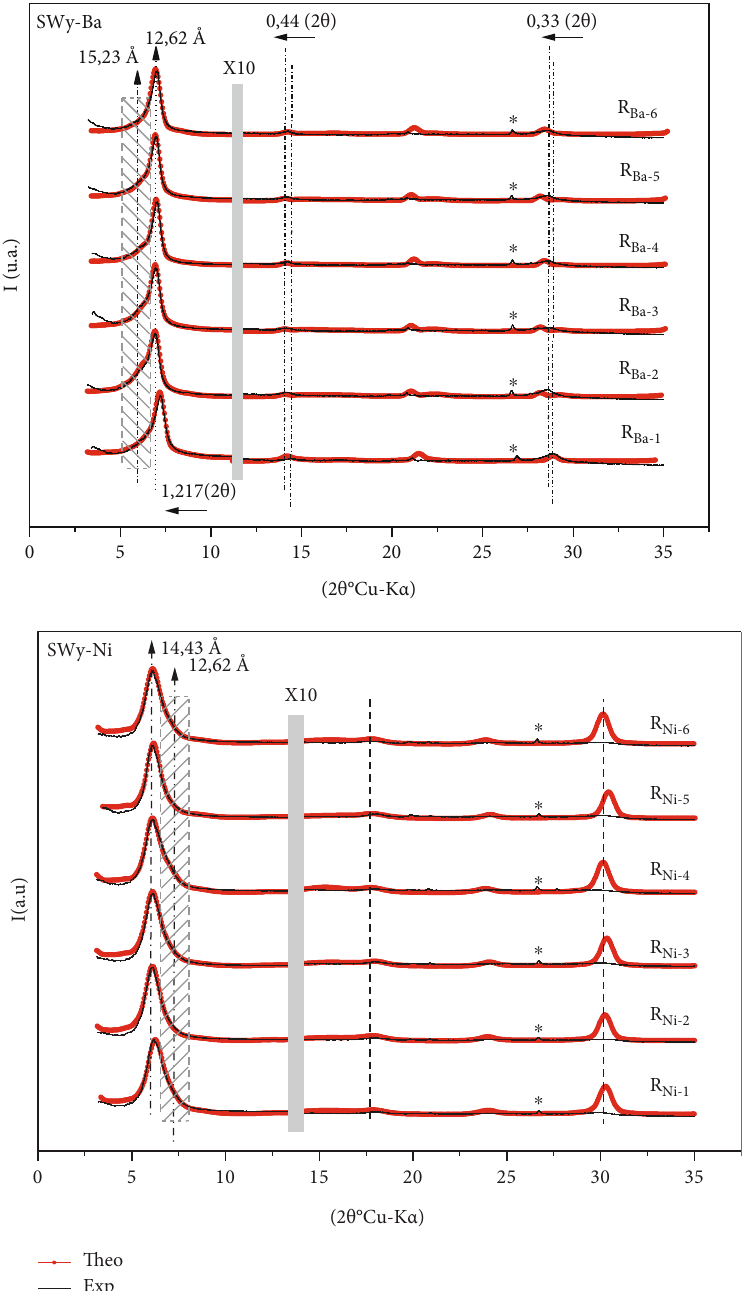
Figure 3: Best agreement between theoretical and experimental XRD pro fi les obtained in the case of the SWy-Ba and SWy-Ni samples. ∗ Halite